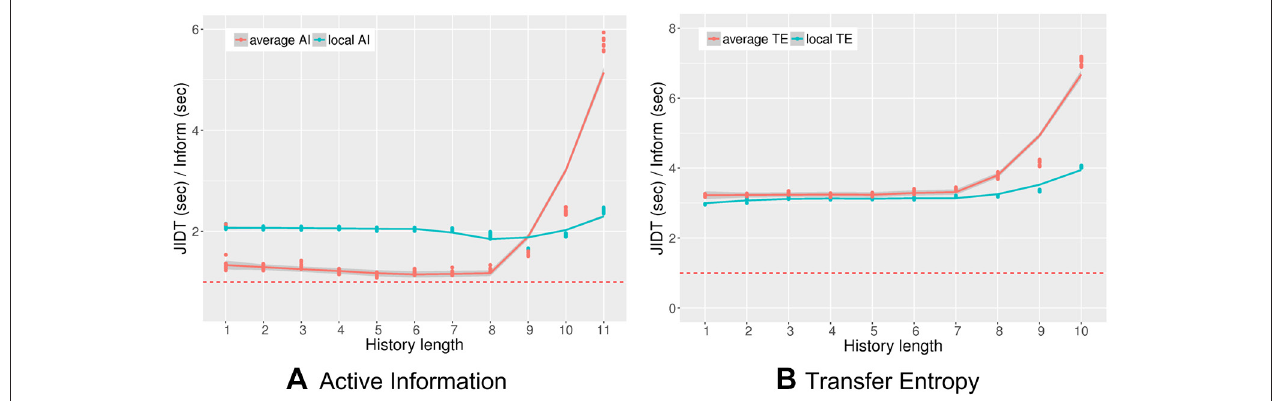
fIguRe 4 | Performance ratio versus history length for average and local active information (A) and average and local transfer entropy (B) The dashed lines mark a performance ratio of 1.0 . Memory constraints limited computation of transfer entropy with JIDT up to k = 10